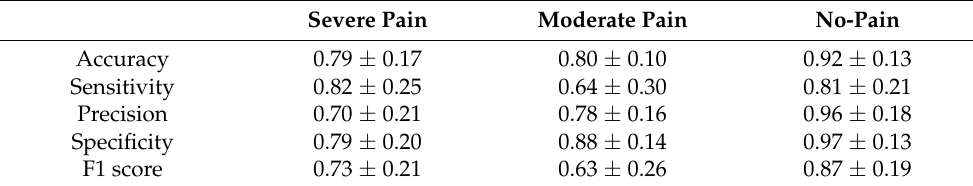
Table 4. Multiclass evaluation results of one-patient-out cross-validation (AdaBoost).